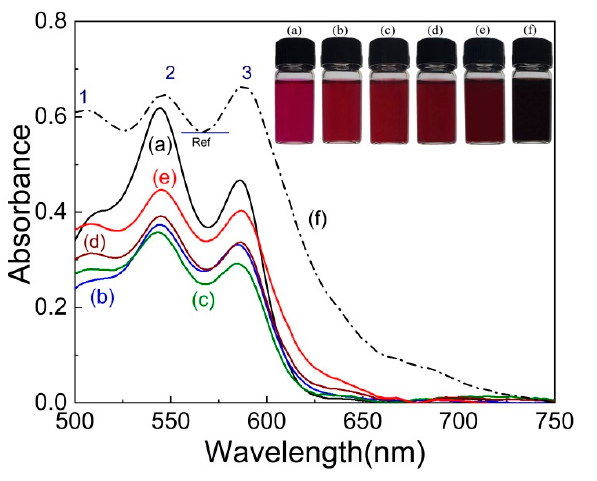
Figure 1. Absorbance and photos of dye that was extracted in aqueous solutions from the leaves of the Tradescantia pallida purpurea plant at different pH values: (a) 3.93, (b) 5.28, (c) 5.45, (d) 6.00, (e) 6.83, and (f) 8.02 (concentration of 0.85 g/mL and 2 mm quartz cuvette). Table 1. The pH values of natural dye solutions that were extracted from Tradescantia pallida purpurea . The relationship of absorption peaks used Ref (Figure 1) as a reference, < λ em > and Stoke (cid:48) s shift. pH Sample ( ±